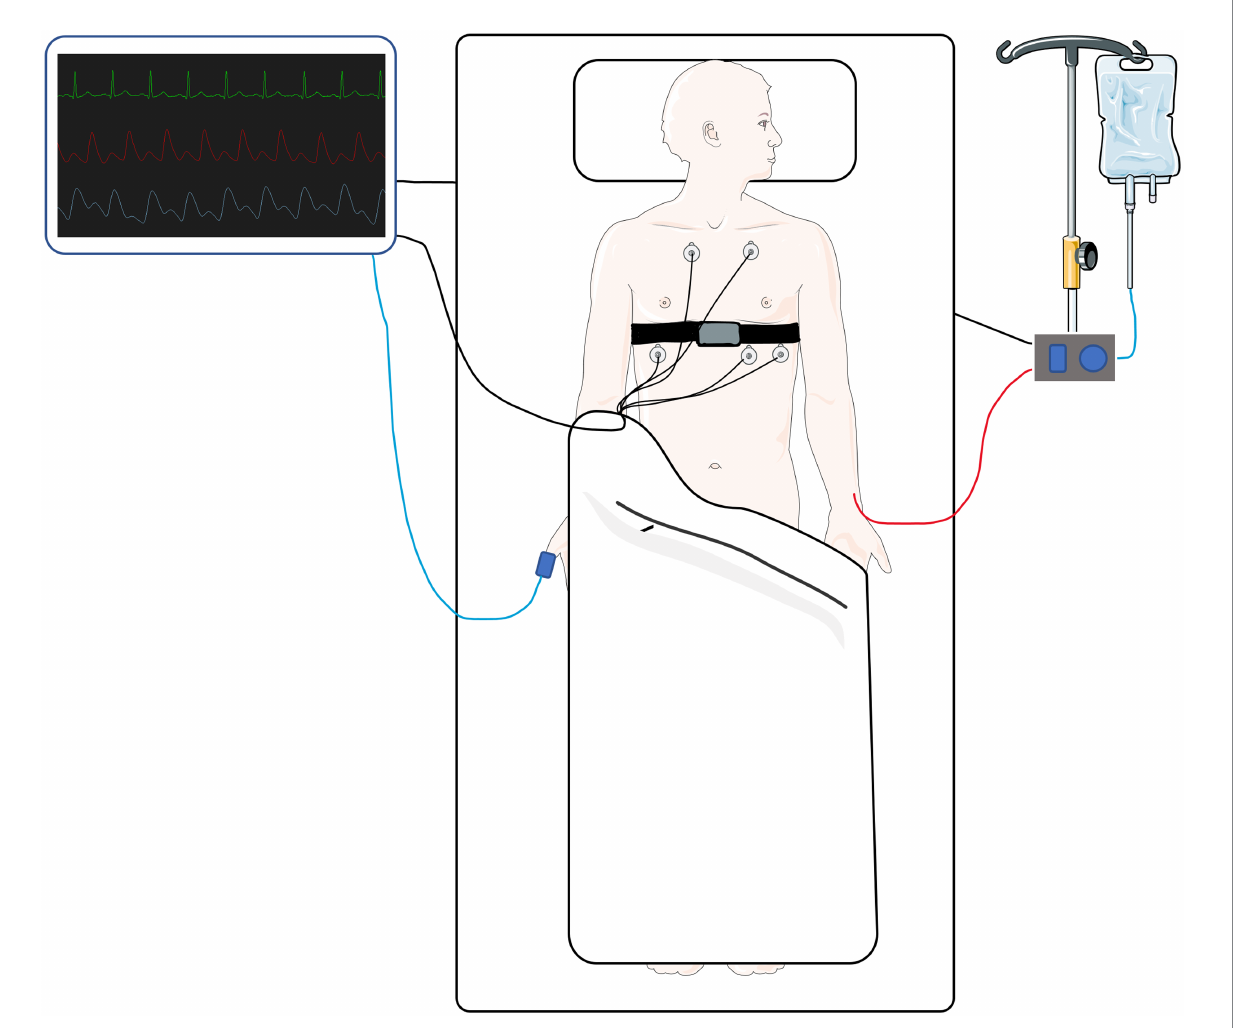
FIGURE 1 A simplified illustration of the chest belt device (cuffless device) fitted on a patient in the intensive care unit alongside basic monitoring equipment. Parts of the figure were created by using pictures from Servier Medical Art. Servier Medical Art by Servier is licensed under a Creative